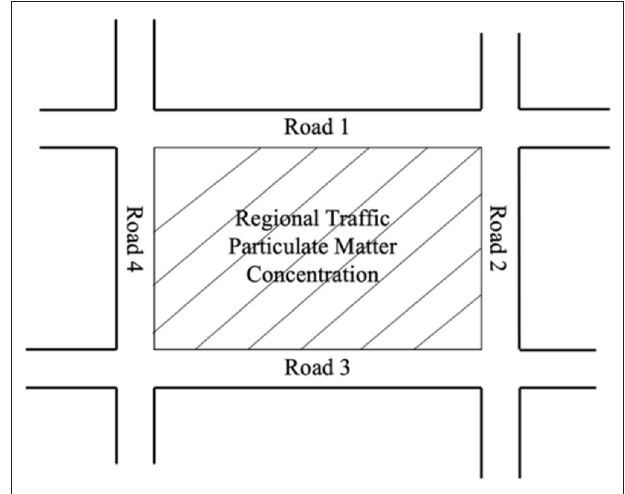
FIGURE 2 | Regional emission concentration and road